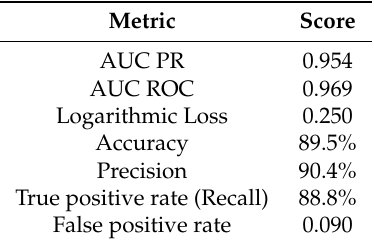
Table 1. Google’s AutoML Model Evaluation Metrics.